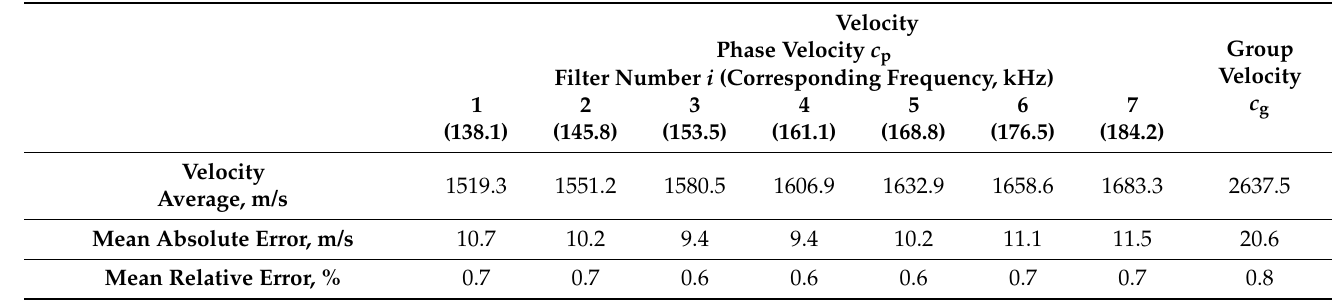
Table 2. The calculations of the velocity averages, the mean absolute errors and the mean relative errors of the phase and group velocities.